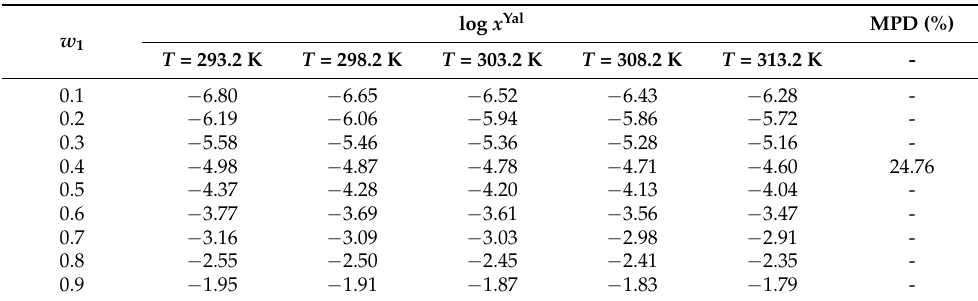
Table 4. Resulting data for “Yalkowsky–Roseman model” for CNZ (3) in different {TP (1) + water (2)} combinations from 293.2–313.2